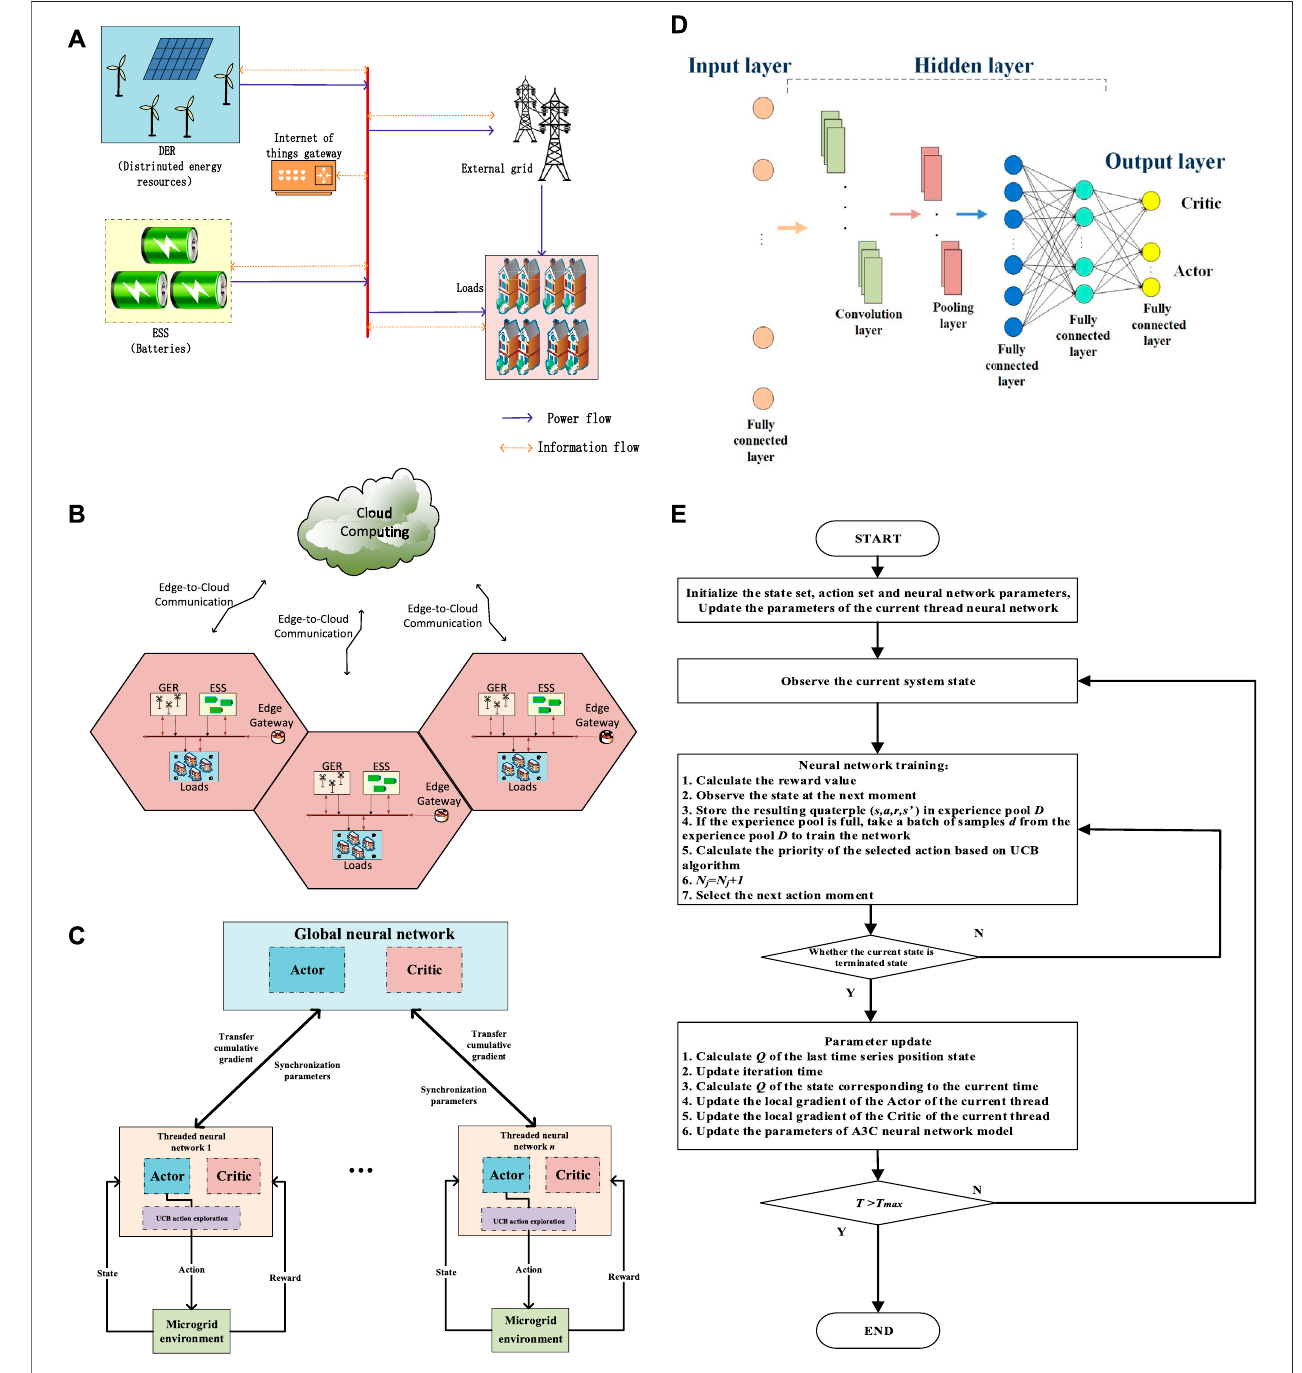
FIGURE1|(A) isthemicrogridmodel, (B) isthemicrogridedgecomputingarchitecture, (C) istheUCB-A3Calgorithm, (D) istheneuralnetworkstructure, (E) isthe microgrid energy management strategy.